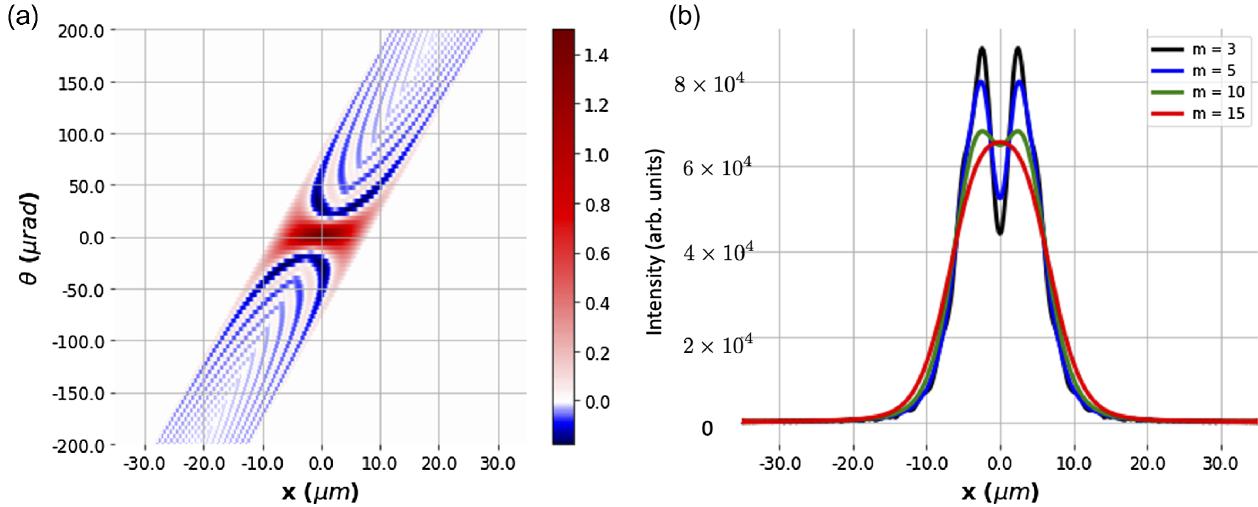
FIG. 5. (a) WFD from Figure 4 for m 2 ¼ 3 after drifting 10 cm. (b) Spatial projections of drifted WFDs for m 2 ¼ 3 , 5, 10 and